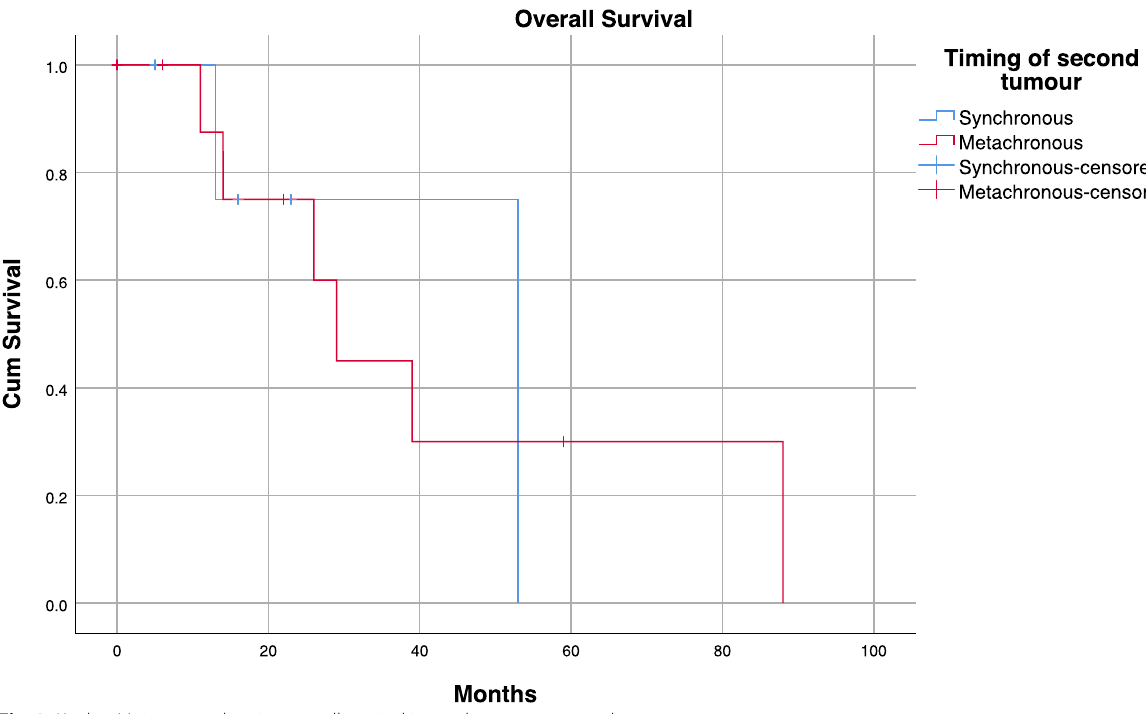
Fig. 2 Kaplan-Meier curve showing overall survival in synchronous vs. metachronous tumors